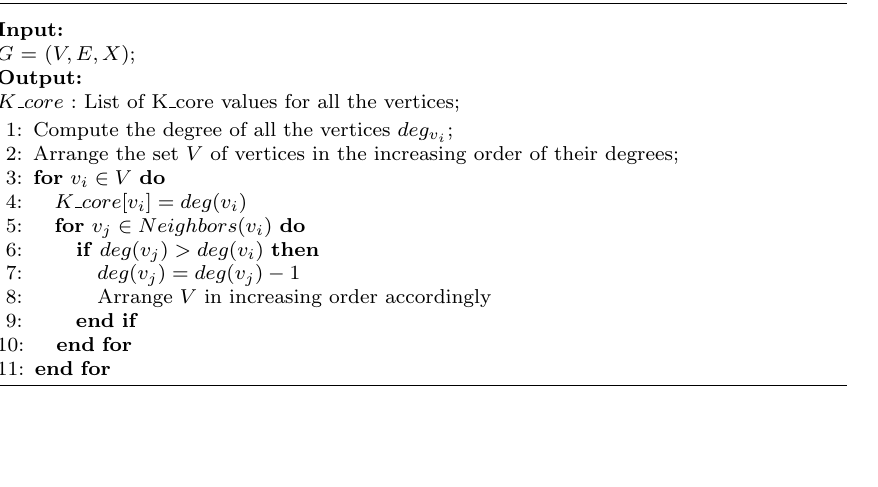
Algorithm 4 Find K core for All